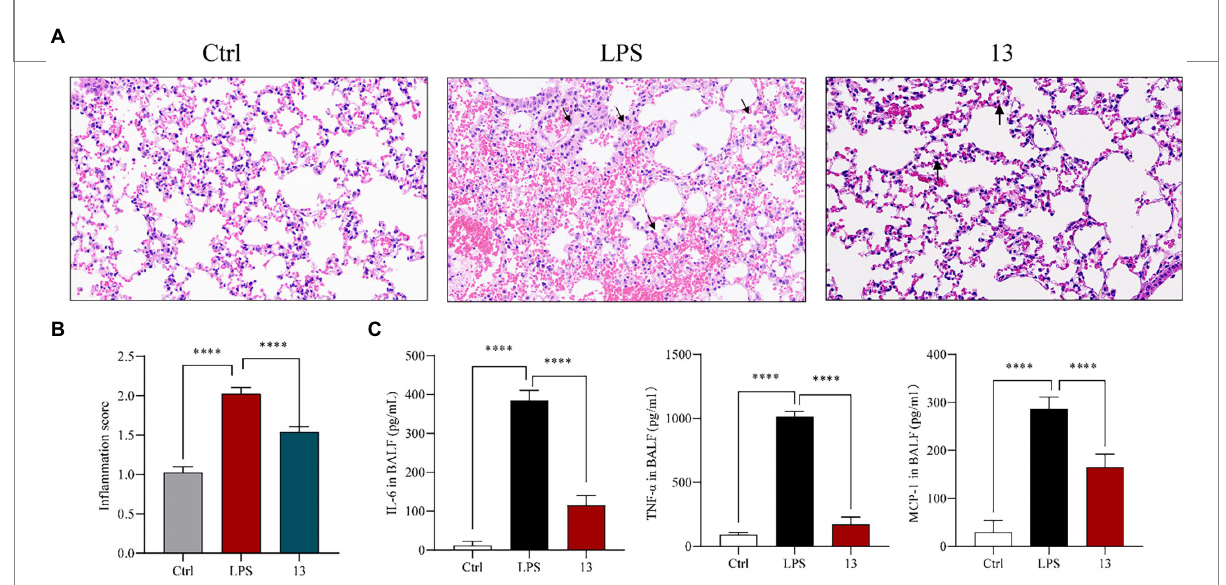
FIGURE 5 Compound 13 weakens the pathological lung injury of LPS-challenged mice. BALB/c mice were intragastric injected with compound 13 for 24 h before the LPS administration. Mice were killed after 6 h of LPS injection (5 mg/kg), and lung histopathology was performed with H&E staining (A) . Inflammation score was measured independently by three pathologists blinded to the experiment ( B , n = 6). The levels of anti-inflammation cytokines in BALF were assayed (C) . **** p < 0.001 vs. control group, n = 6. p value was assessed by two-tailed Student’s t